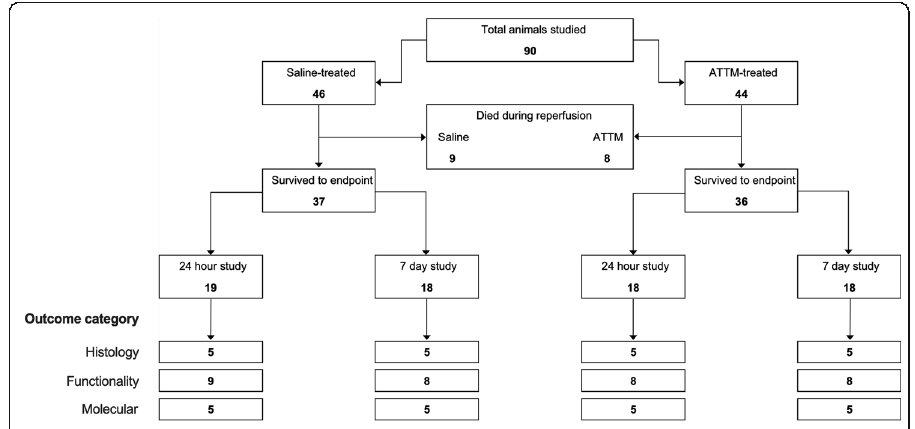
Fig. 1 Experimental design. Flow diagram depicting the number of animals used for each category of outcome